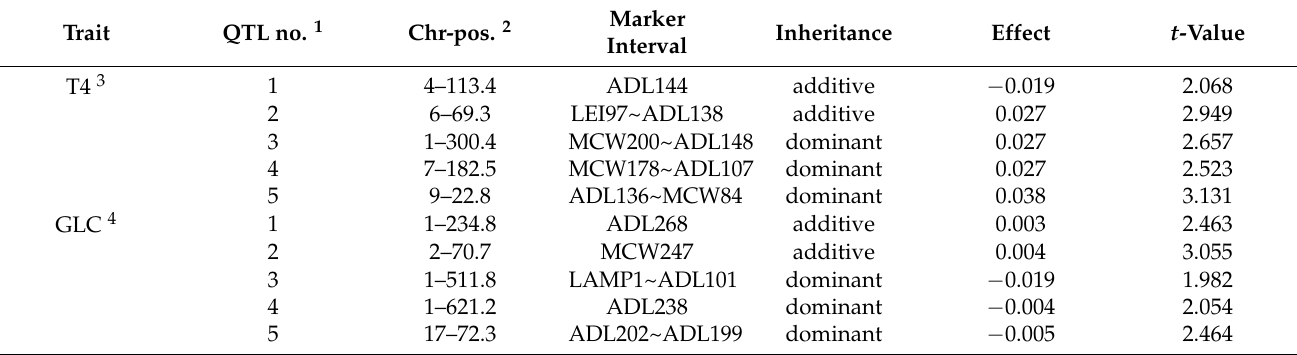
Table 2. QTLs for the allometric scaling of two metabolic traits to body weights.